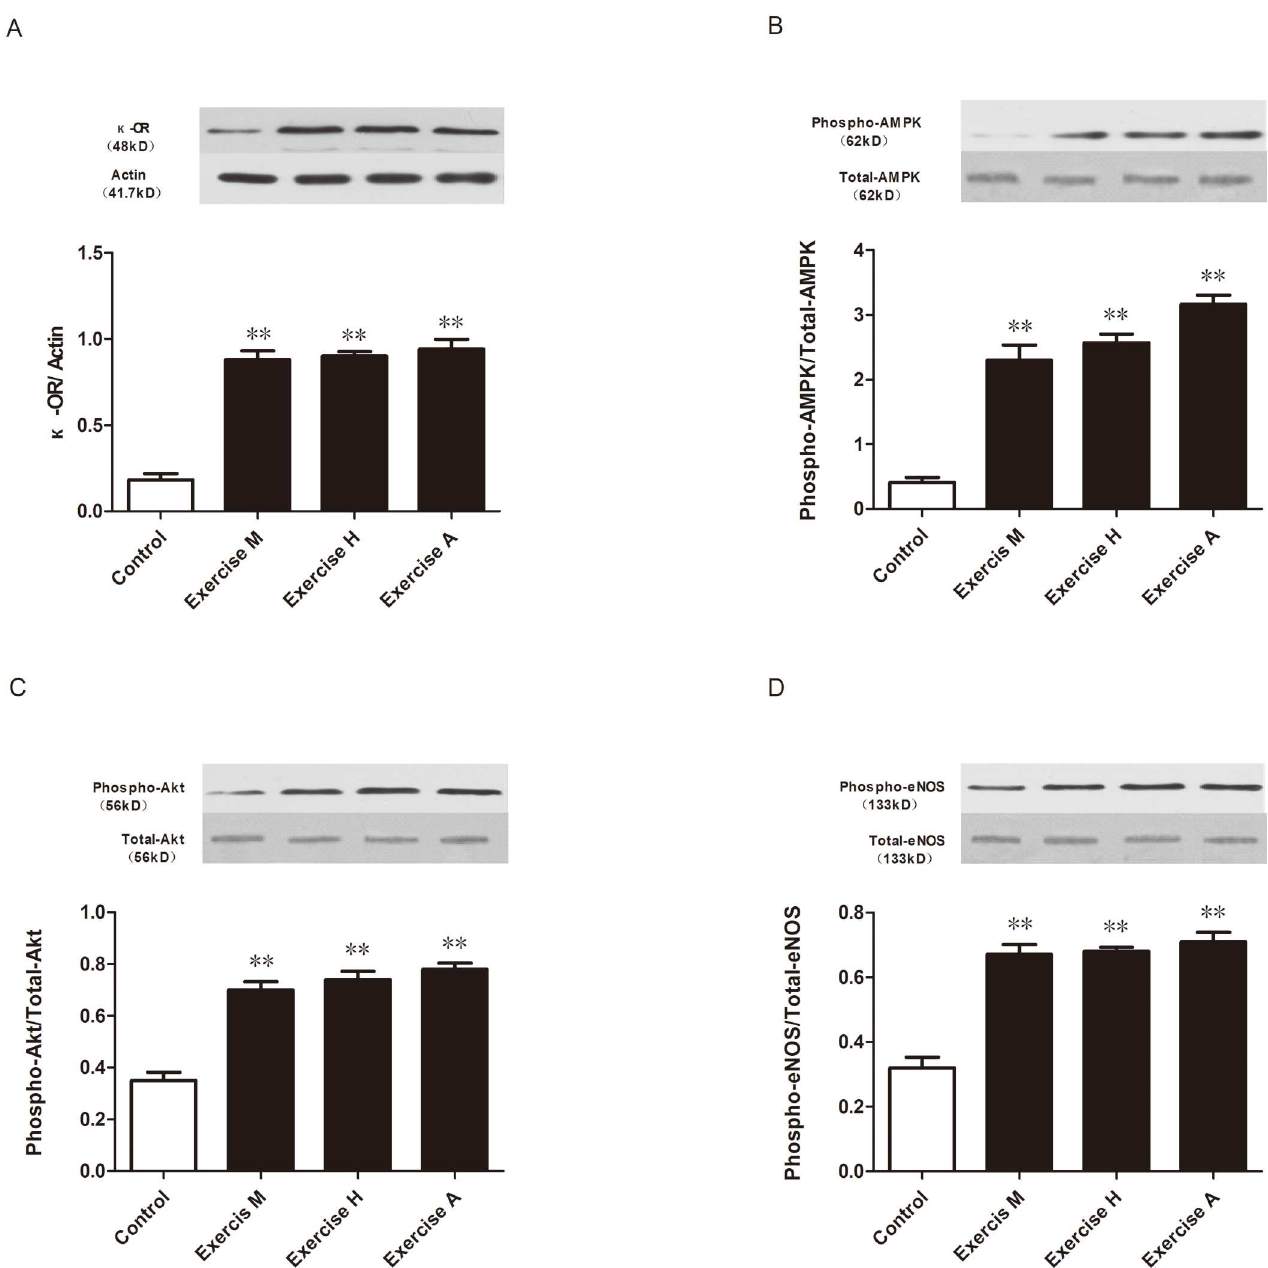
Fig 4. Effects of exercisetraining with different intensities on expression of κ -OR (A), AMPK (B), Akt (C) and eNOS (D) . All of the results are expressedas the means ± SEMs. ME, moderate intensity exercise for 8 wk; HE, high intensity exercise for 8 wk; AE, acute exercise. n = 8, ** P < 0.01vs.